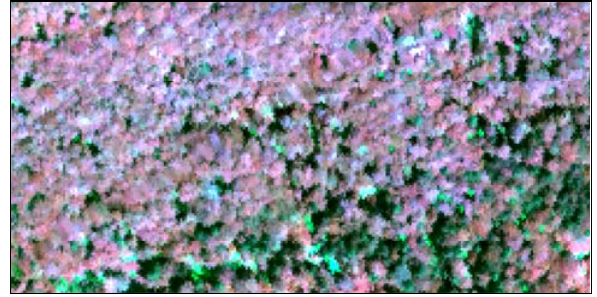
Figure 4. False color composite APEX image (Red: 860nm; Green: 650nm;Blue: 552nm)